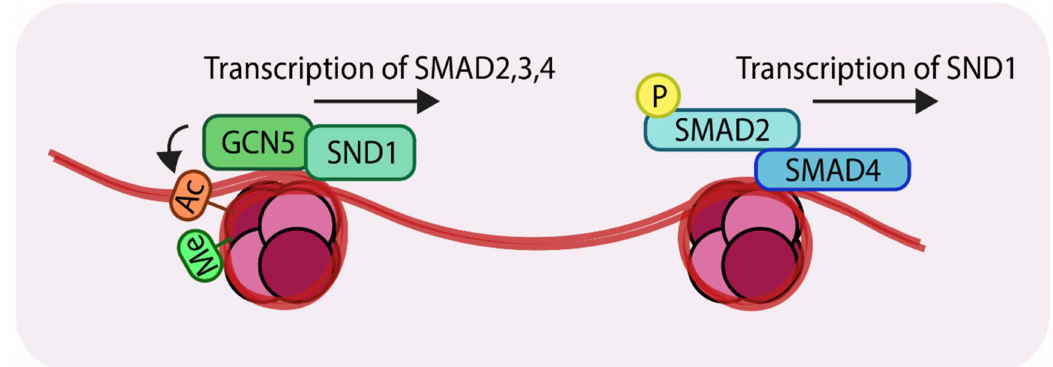
Figure 4. Representation of the action of the histone acetyltransferase, GCN5 (General control non-repressed protein 5) ( Left ); SND1 (Staphylococcal nuclease domain-containing 1) recruits GCN5 to the promoter regions of SMAD2 , 3 and 4 . GCN5 acetylates at H3K9 which results in transcriptional activation. ( Right ) The SMAD complex can further enhance transcription of SND1 creating a positive feedback loop. ‘Ac’ in orange circles indicates acetylation, ‘Me’ in green circles indicates methylation and ‘P’ in yellow circles indicates